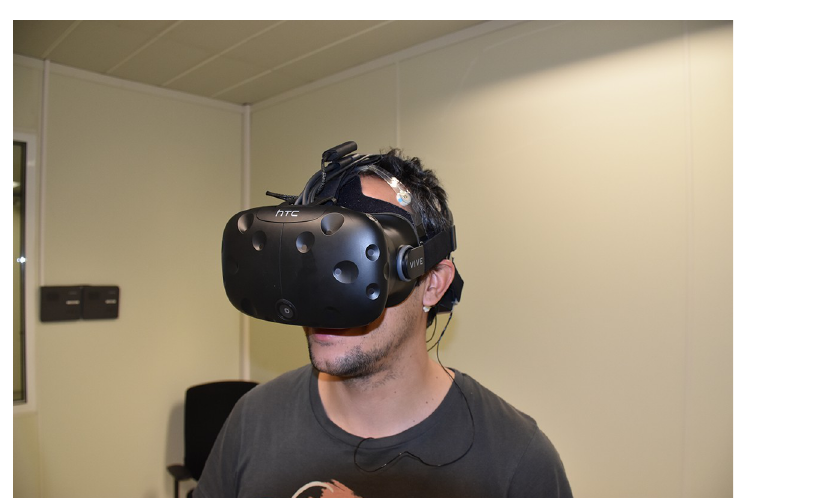
Fig 3. Example experimental setup in the virtual museum.